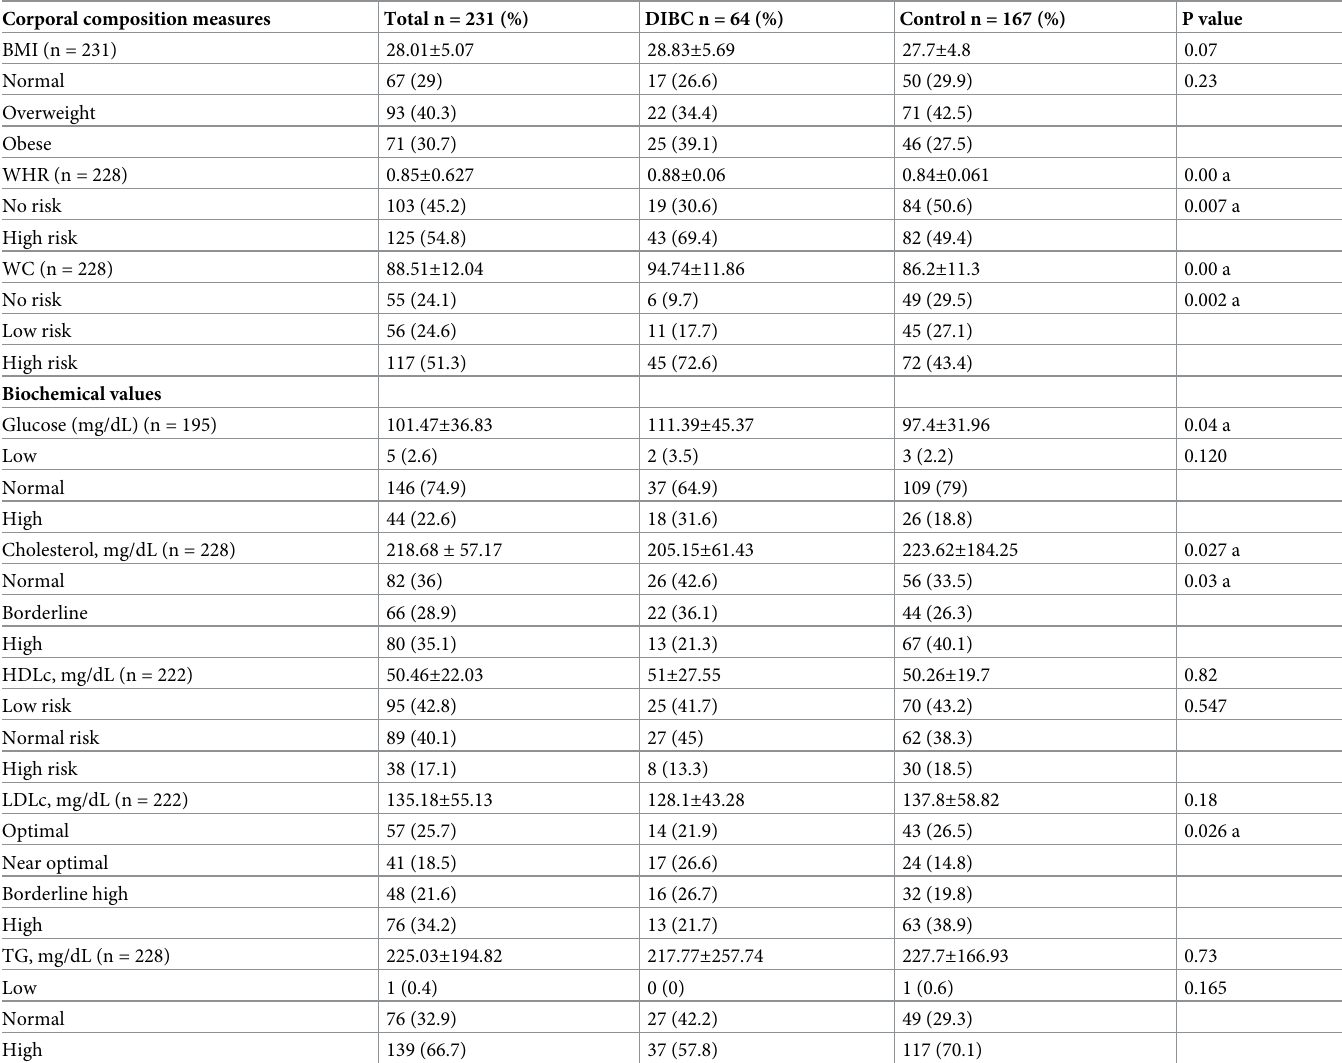
Table 1. Anthropometric measures and lipid and glucose profile comparison between women in the control and DIBC groups. Corporal composition